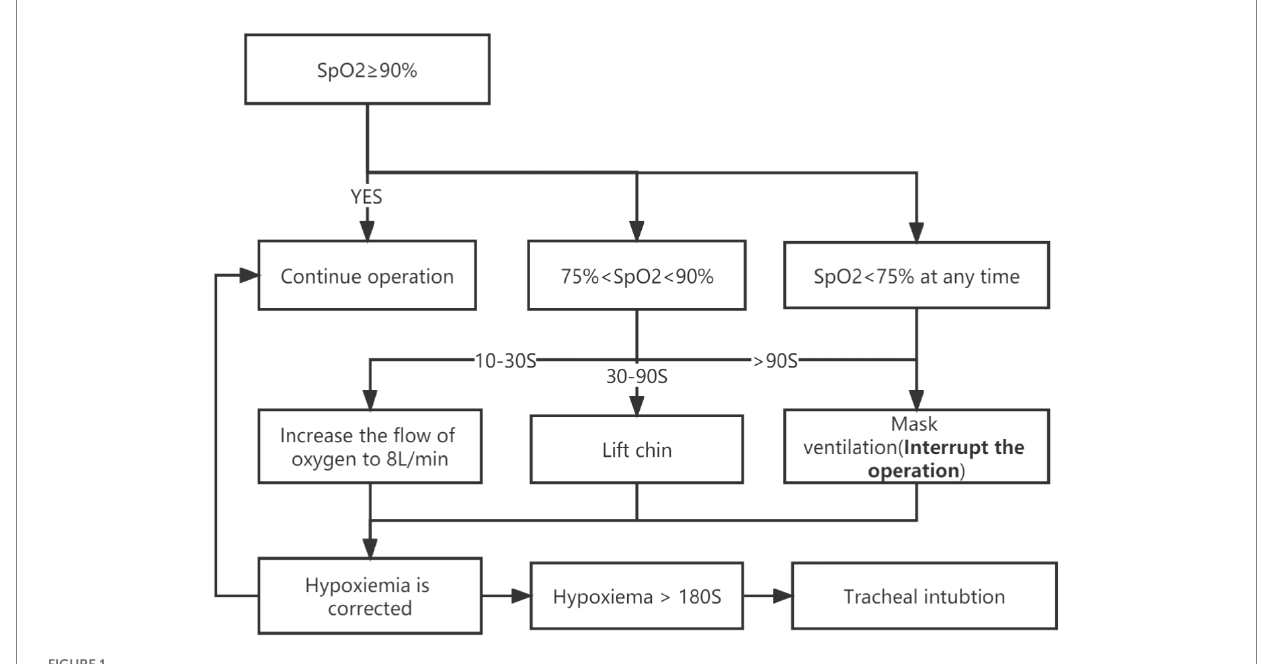
FIGURE 1 Flowchart of hypoxemia management. SpO 2 indicates pulse